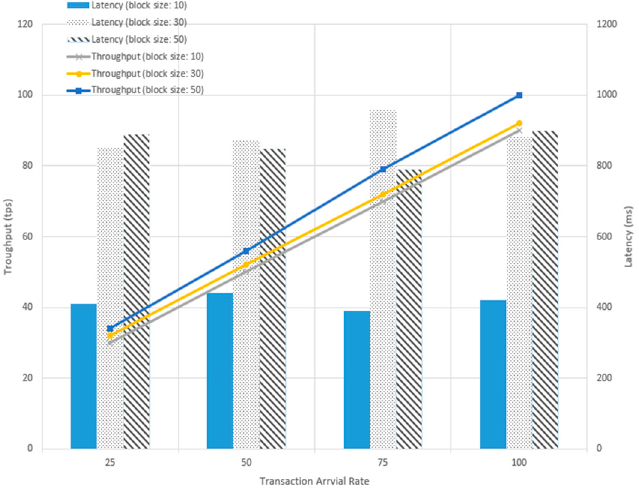
Figure 6. Time cost of getting data information from the blockchain for different block sizes and transaction arrival rates.